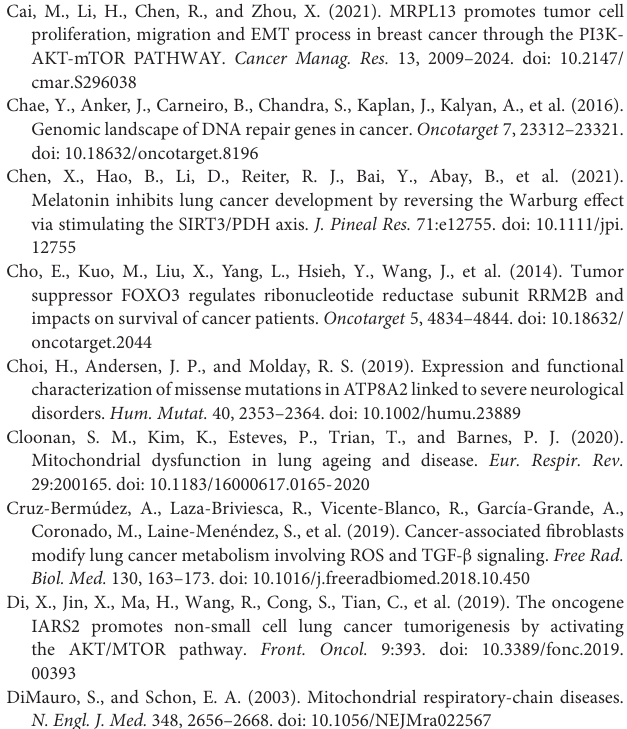
Supplementary Figure 1 | Comparison of clinical characteristics between the high-risk and low-risk groups. Supplementary Figure 2 | The therapeutic benefit of the risk score value. Kaplan-Meier OS curves for patients who received radiation therapy assigned to high- and low-risk groups in the TCGA